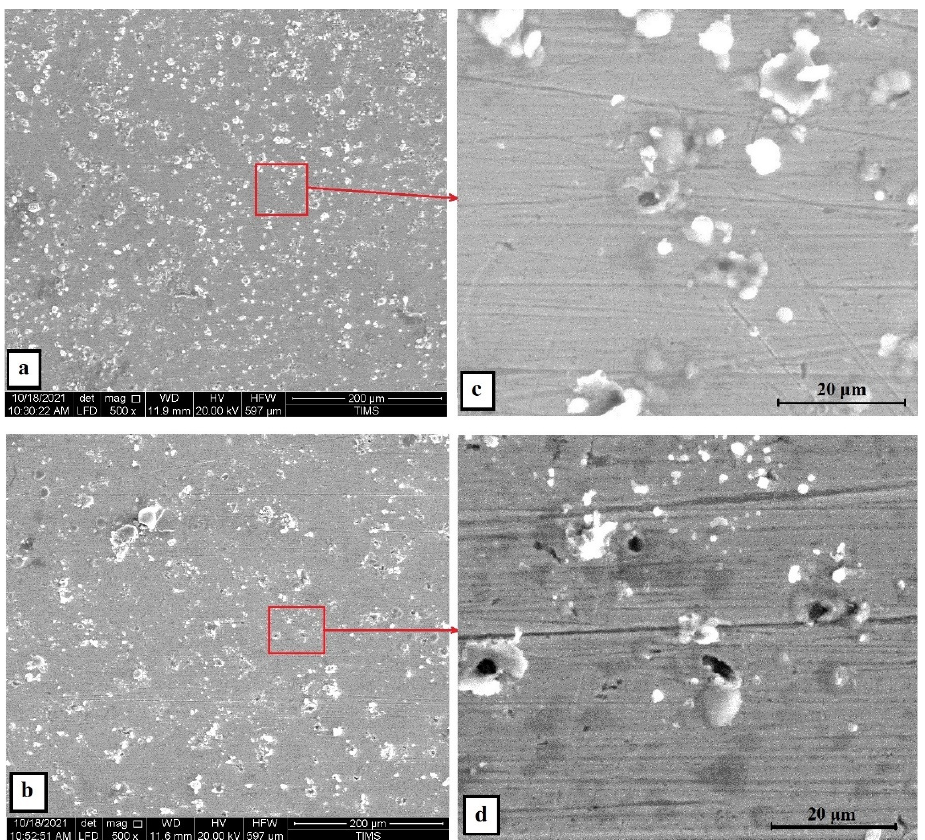
Figure 16. The SEM surface morphologies of the Fe 36 Mn 20 Ni 20 Cr 16 Al 5 Si 3 HEA ( a ) as cold-rolled and ( b ) solution-treated condition after subjected to 0.6 M NaCl + 1 M H 2 SO 4 solution, ( c ) the zoomed-in area of ( a ), and ( d ) the zoomed-in area of ( b ).